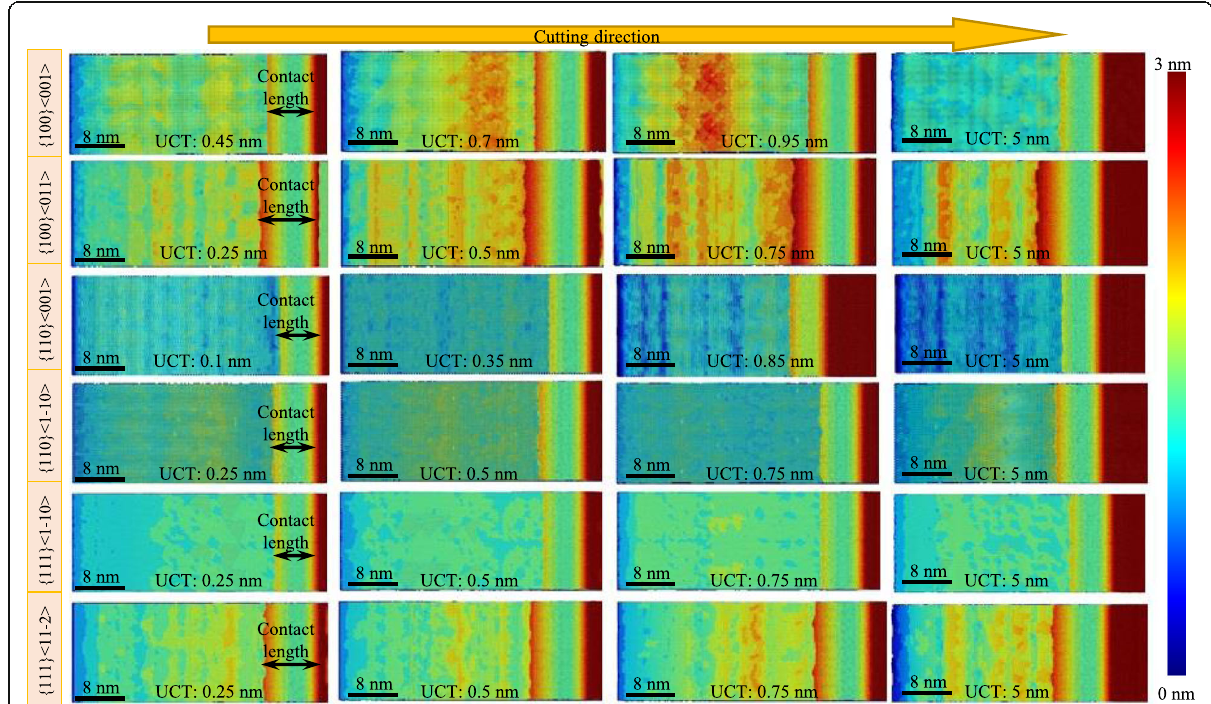
Fig. 15 Surface generation at different cutting directions and